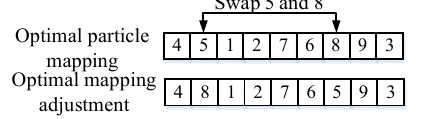
Figure 4. Optimal particle mapping adjustment.